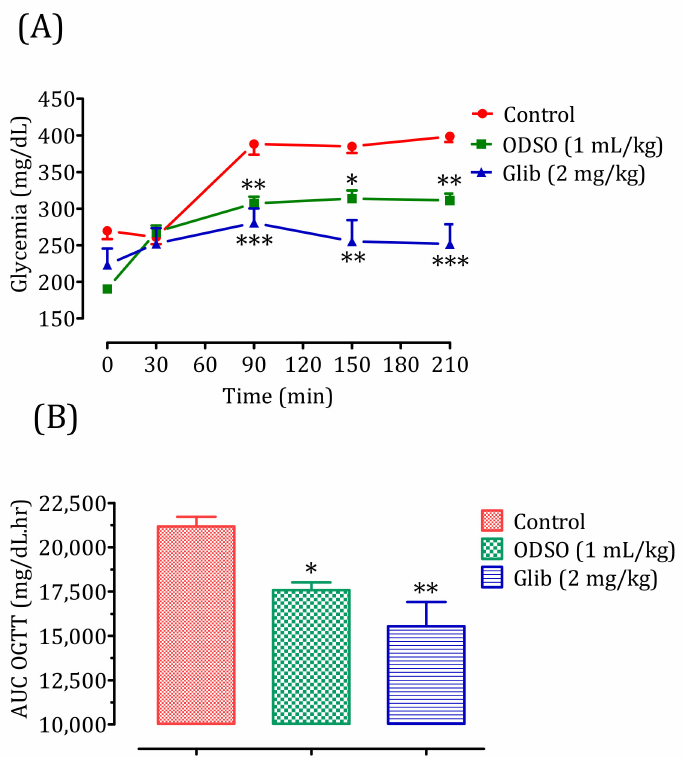
Figure 3. Effect of the oil (ODSO) and glibenclamide (Glib) on the postprandial glycemia variations in diabetic rats ( A ), with a representation of the area under curves ( B ). ODSO: Opuntia dillenii seed oil. The values are the means ± SEM ( n = 6). * p < 0.05, ** p < 0.01, and *** p < 0.001 compared to the